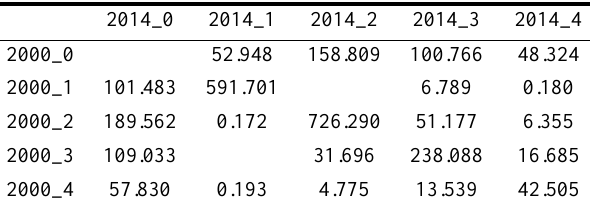
Table 2 Classified lake transfer matrix from 2000 to 2014 (Unit: